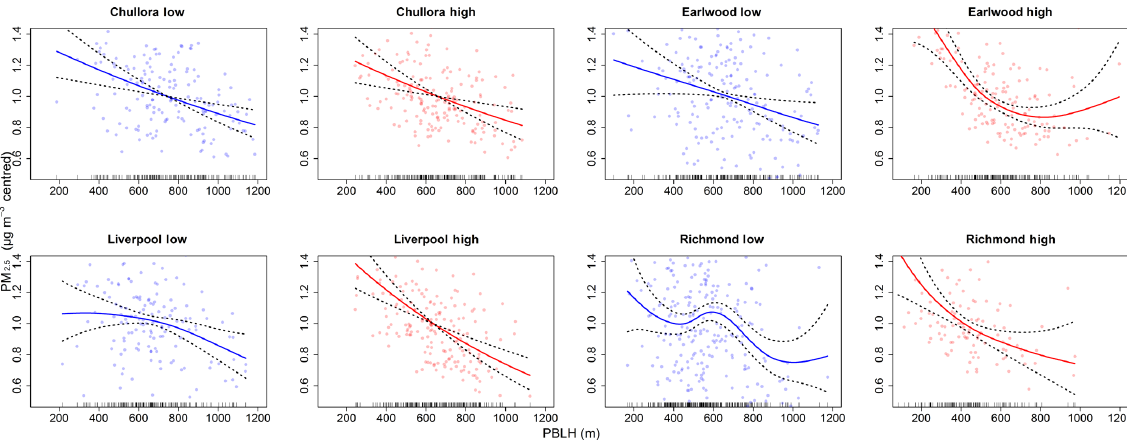
Figure 6. The contribution by the planetary boundary layer height (PBLH) component of the generalised additive mixed model (GAMM) linear predictor to fitted PM 2 . 5 values (µgm − 3 , centred). The solid lines are the fitted curves. Dotted lines are 95% confidence bands. Dots are partial residuals.